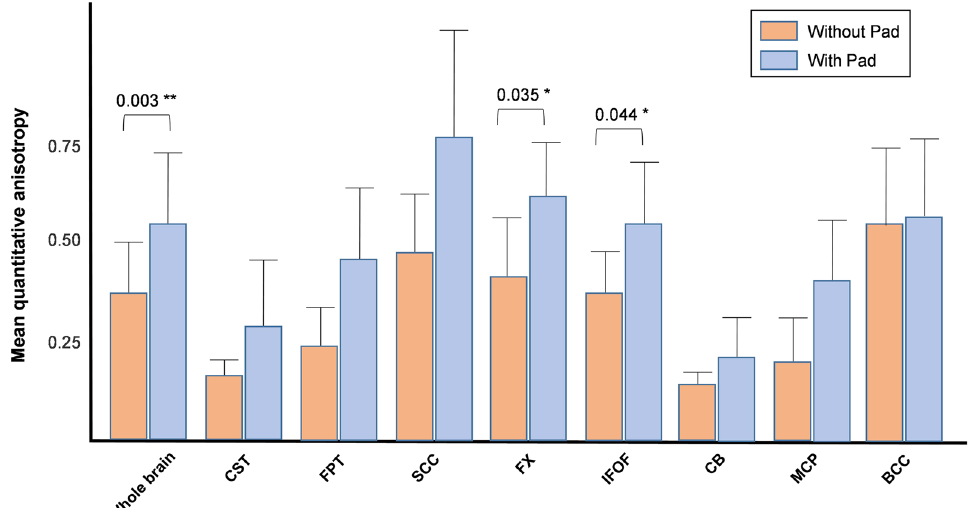
Fig. 5 A bar graph showing the comparison between mean quantitative anisotropy (QA) values with and without the use of high‑dielectric pad. Asterisk denotes significant difference with increased QA value when compared to that without pad. CST Corticospinal tract; FPT Frontopontine tract; SCC Splenium of corpus callosum; FX Fornix; IFOF Inferior fronto‑occipital fasciculus; CB Cerebellum; MCP Middle cerebellar peduncle; BCC Body of corpus callosum